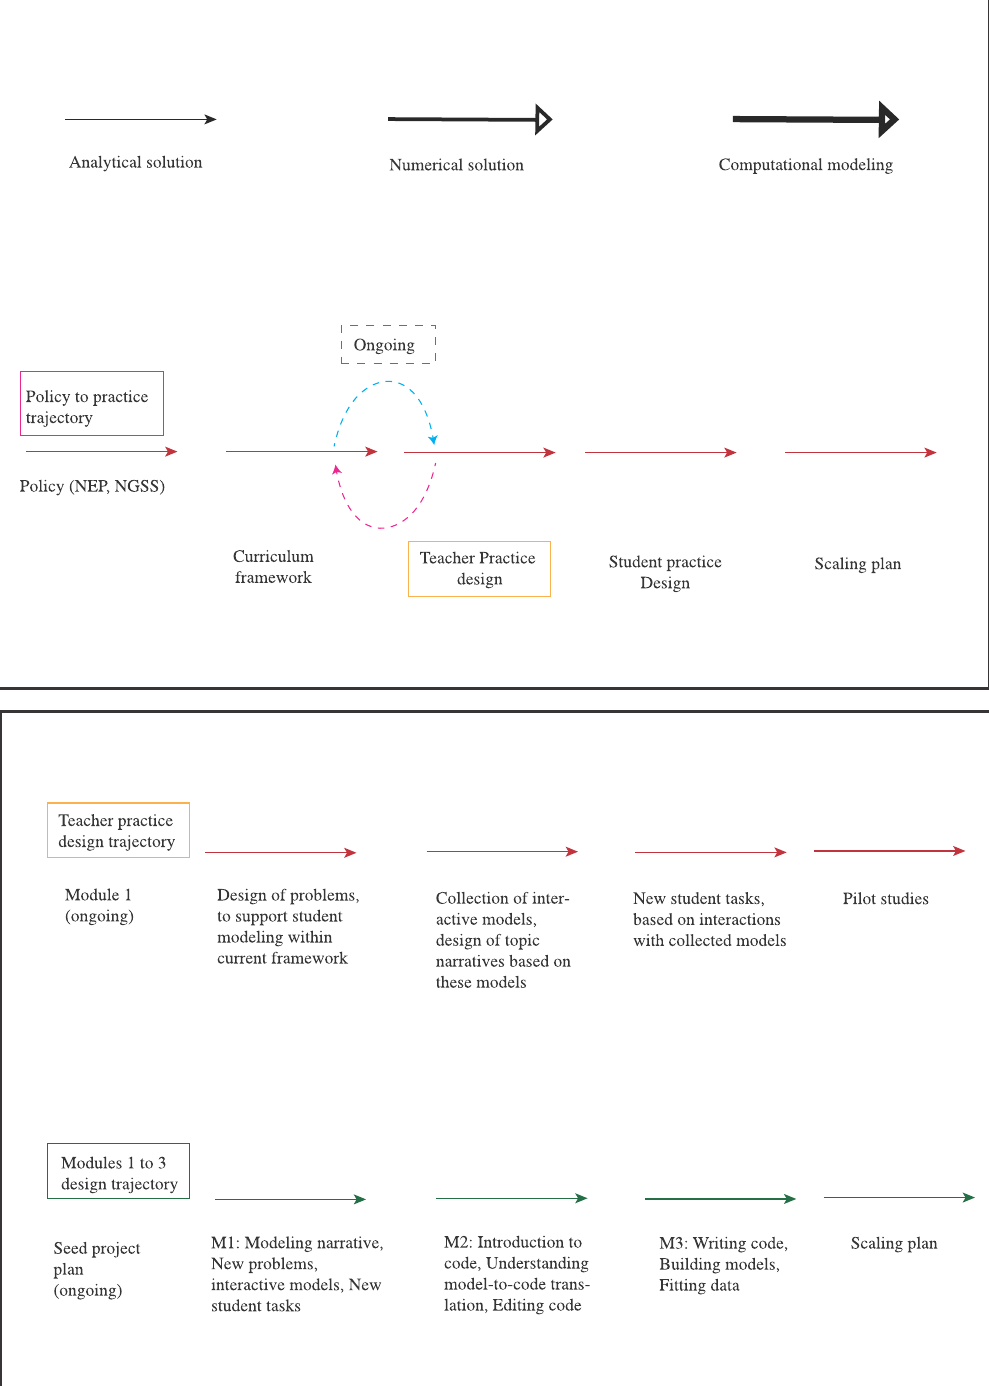
FIG. 2. Outline of the projected design sequence of the workshop for